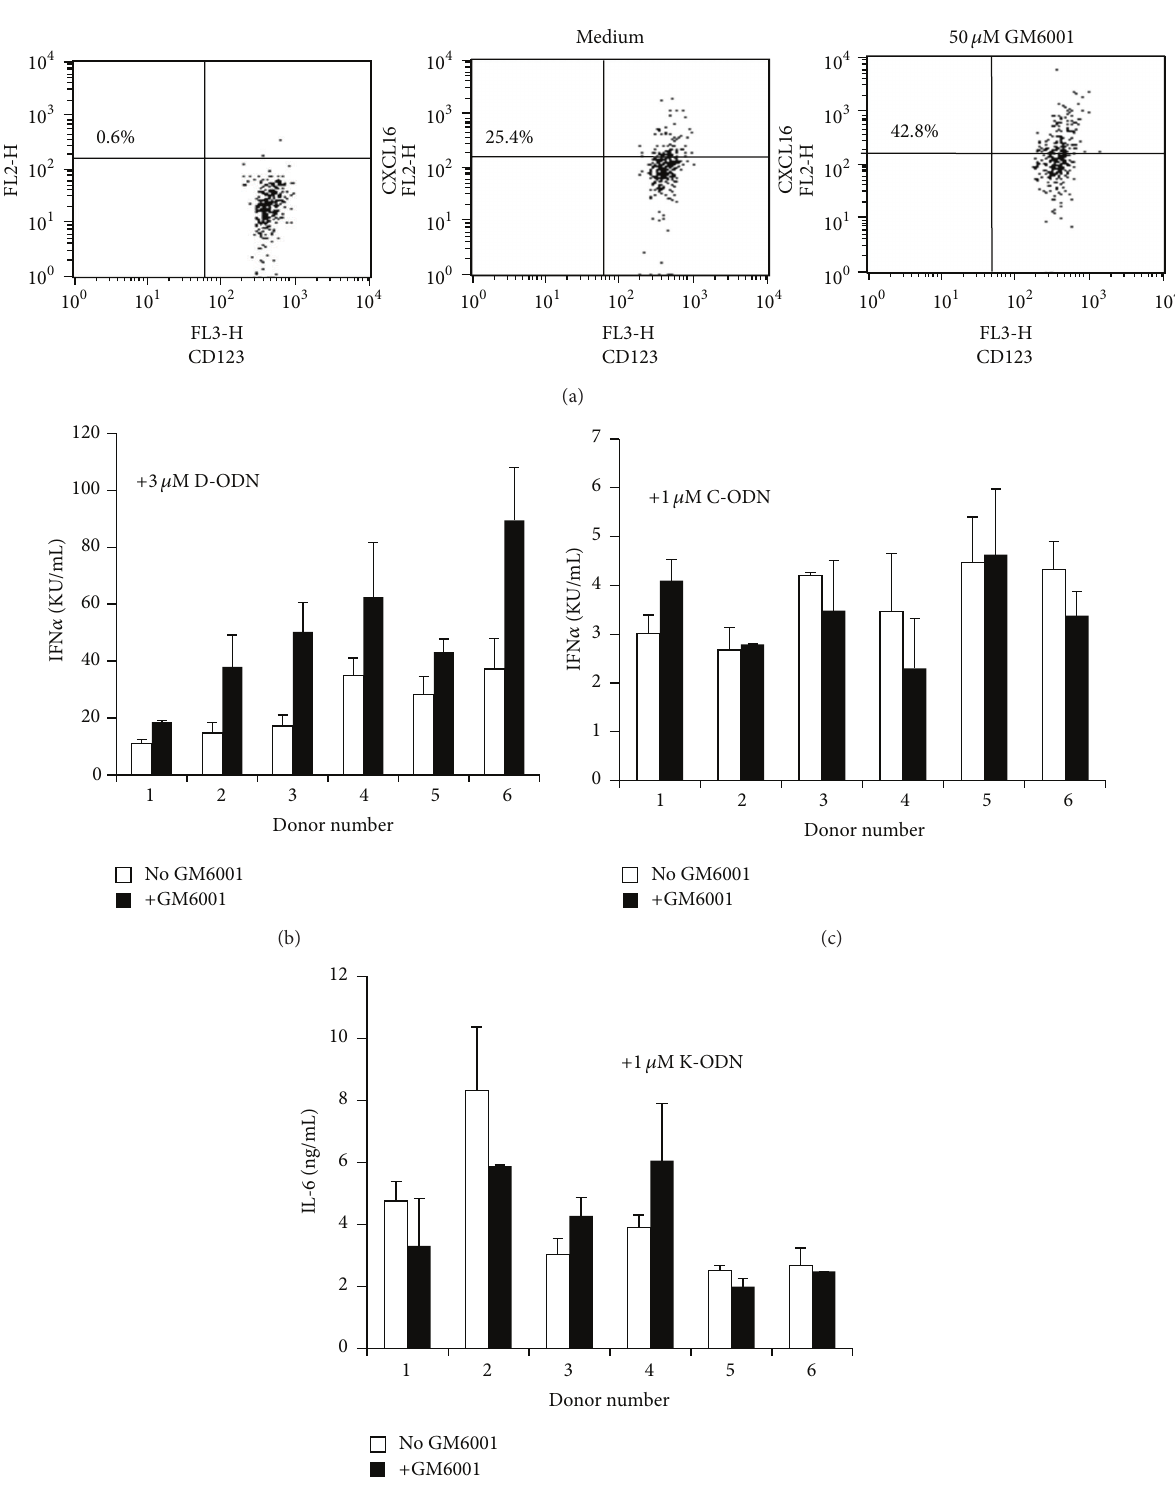
Figure 1: Metalloproteinase inhibitor GM-6001 enhances cytokine production induced by D-ODN. (a) PBMC (4 × 10 6 /mL) were preincubated in the absence or presence of GM6001 (50 𝜇 M) for 30 min, fixed, and stained for CXCL16 expression. Cells treated as in (a) were washedandthenstimulatedwith3 𝜇 MD-ODN(b),1 𝜇 MofCODN(c),or1 𝜇 MofK-ODN(d)for24 h.Cytokineproduction(IL-6forK-ODN and IFN 𝛼 for D and C ODN) was assessed from culture supernatants using ELISA. Response of 6 individual donors is